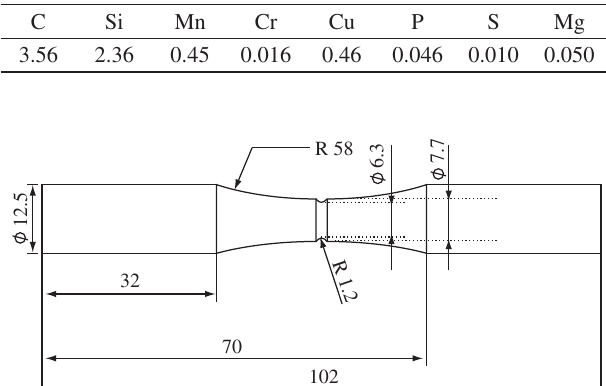
Table 1. Average chemical analysis results (in weight %).